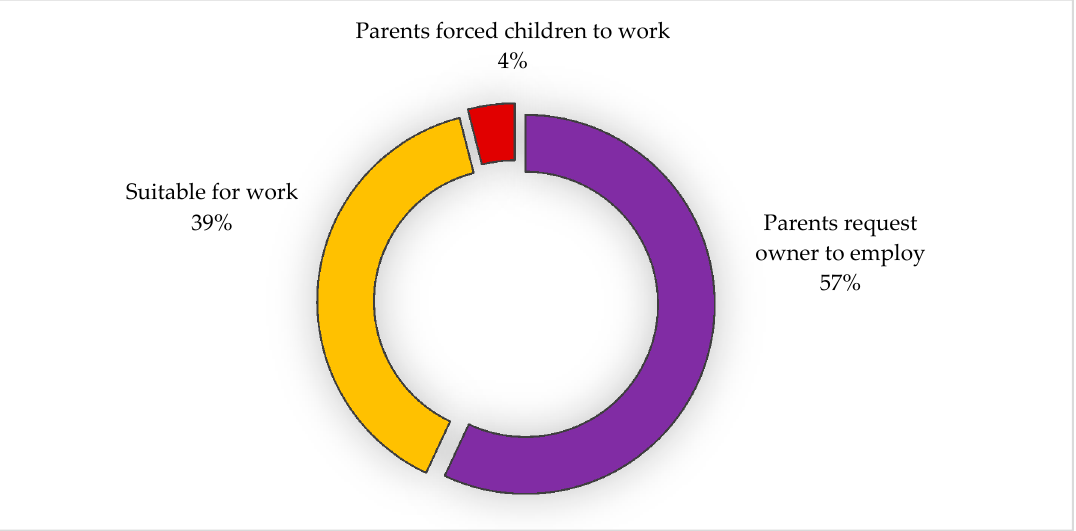
Figure 5. Reasons behind employing children for fish drying activities in the study areas.